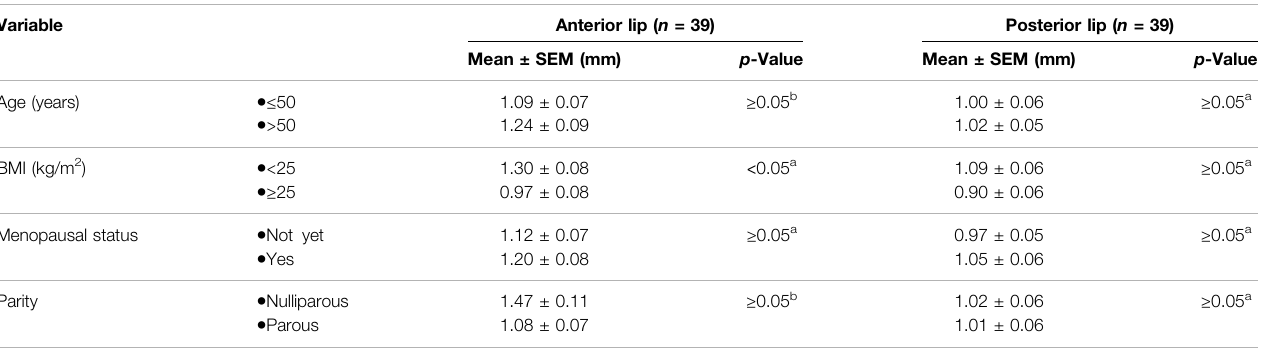
TABLE 3 | Differences in the mean depth of tissue destruction based on subject characteristics.